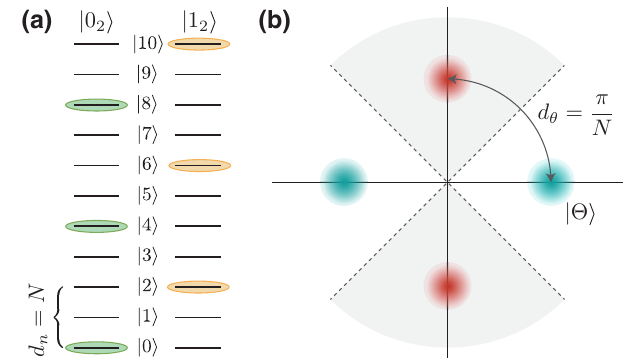
FIG. 1. Fock space and phase-sector structure of RSB codes with order N = 2 rotation symmetry. (a) The computational states of order- N codes have support only on each 2 N th Fock state, with the | 1 N (cid:2) state offset by N from the | 0 N (cid:2) state. This introduces a number distance d n = N between the codewords. (b) The dual basis code states |± N (cid:2) can be constructed as the superpositions of N rotated primitive states | (cid:4) (cid:2) . Here, we asso- ciate the blue (red) primitive states to the |+ 2 (cid:2) ( |− 2 (cid:2) ) dual-basis code word that occupies the white (gray) phase sectors exclu- sively. The number distance d n of computational states | μ N (cid:2) translates to a rotational distance d θ = π/ N for dual-basis states |± (cid:2) . N diag ( 1, 1, 1, − 1 ) gate, state preparation P | (cid:6) of N (cid:2)